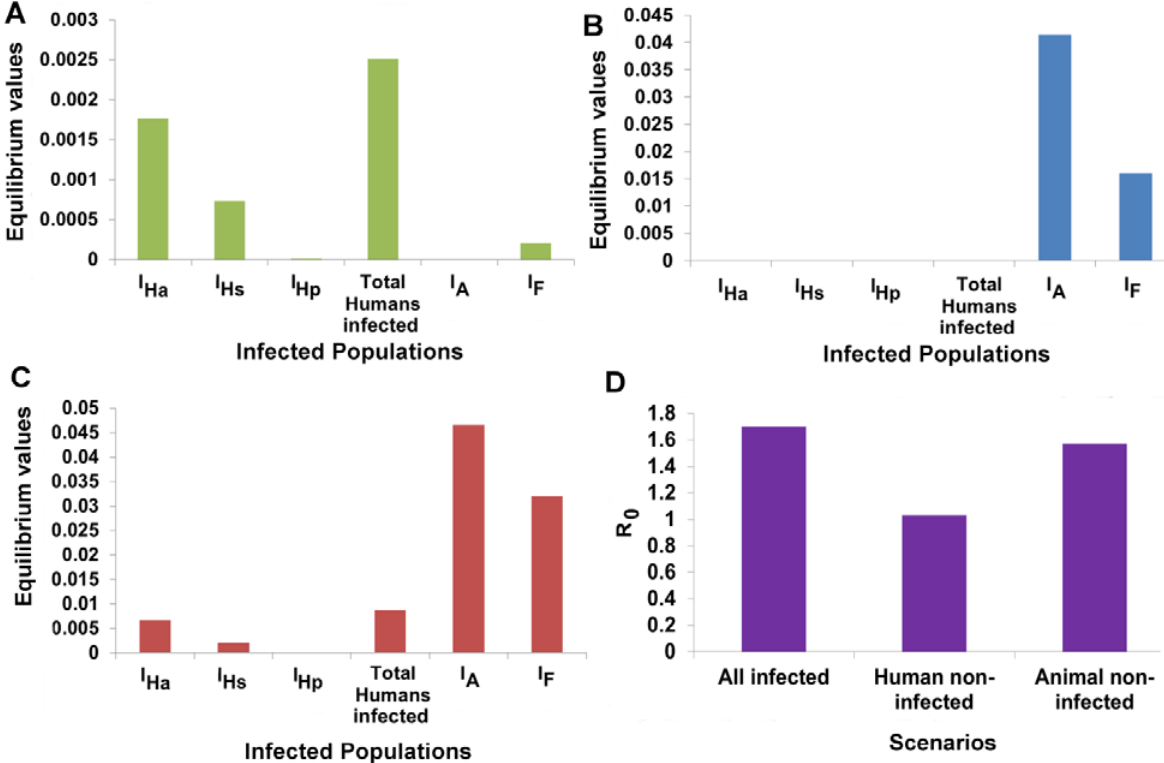
Figure 3. Comparison of equilibrium and R 0 values in different scenarios created from the model. ( A ) Comparison of equilibria of infected populations in the non-infected animal scenario; ( B ) Comparison of equilibria in the non-infected human scenario; ( C ) Comparison of equilibria in the default, all infected scenario; ( D ) R 0 values in the above three